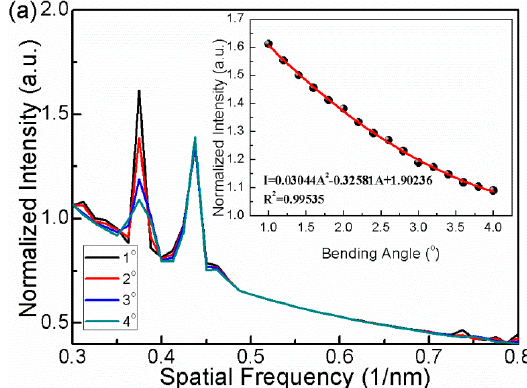
Figure 8. Cont . Figure 8. Cont .